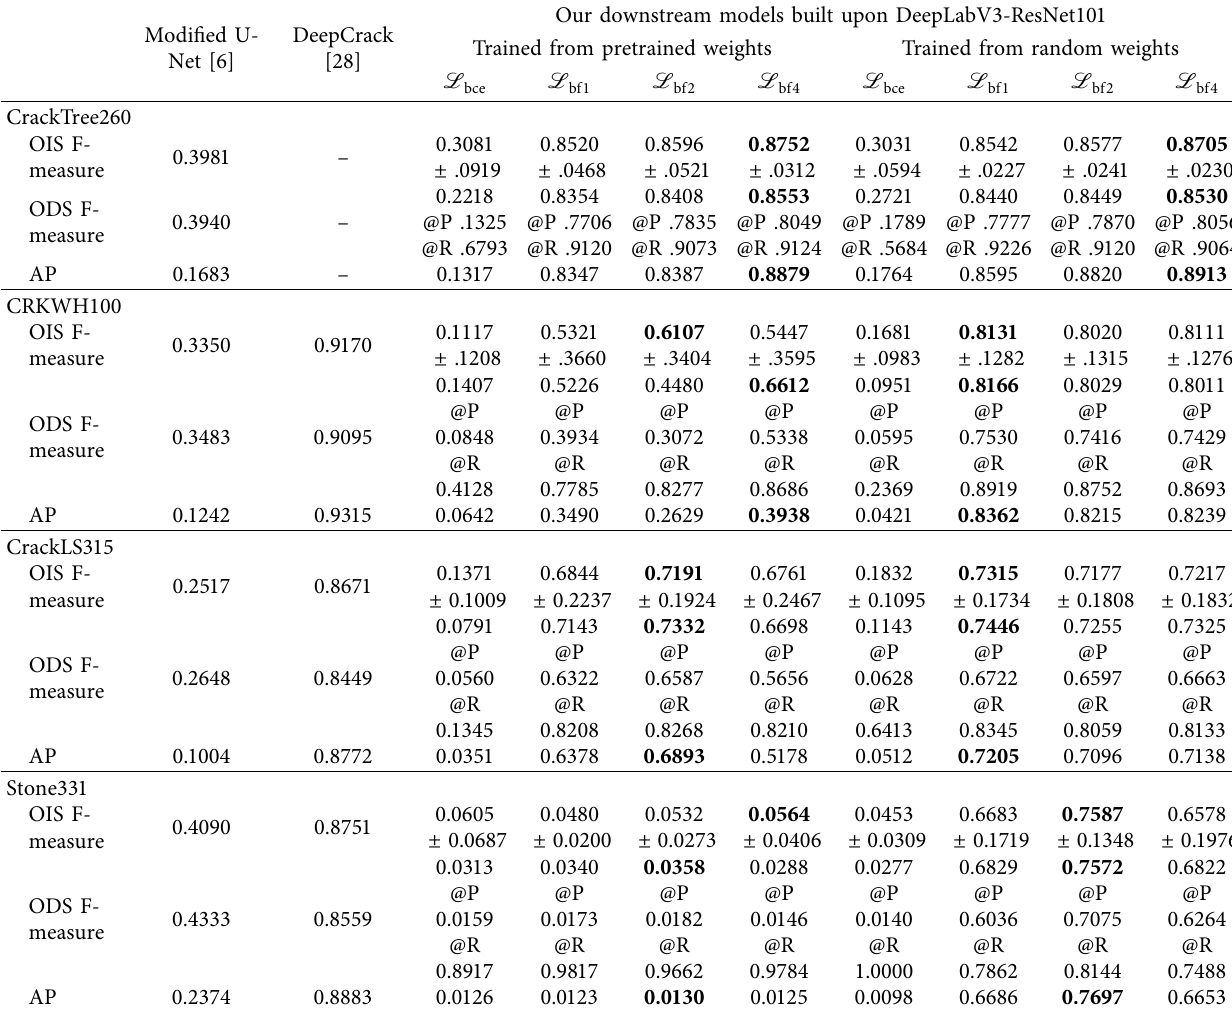
Table 3: Comparing our downstream models built upon DeepLabV3-ResNet101 with other works of deep-learning-based low-level crack detection on the same test datasets; the flexibility value of d � 2 is used in all evaluations. While ODS F-measure is reported with its corresponding precision (P) and recall (R) as written underneath, OIS F-measure is reported together with its standard deviation (written with a leading ± symbol) showing the dispersion of the optimal image-scale F-measure in a particular test dataset. For each training strategy of us, the best (maximum) value among the four loss functions is highlighted in bold. Our downstream models built upon DeepLabV3-ResNet101 Trained from pretrained weights Trained from random weights